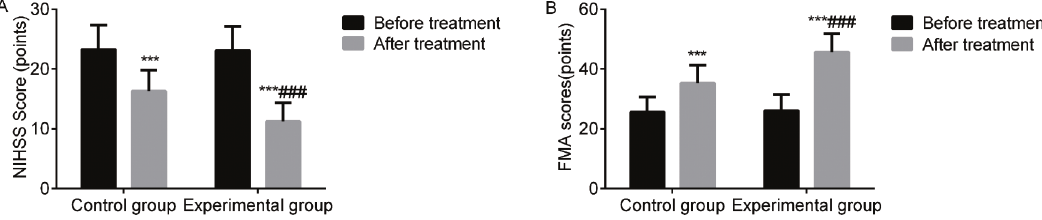
Figure 4 - Comparison of the NIHSS and FMA scores between the two groups before and after treatment. Note: compared with the group before treatment, *** p o 0.001; compared with the control group, ### p o